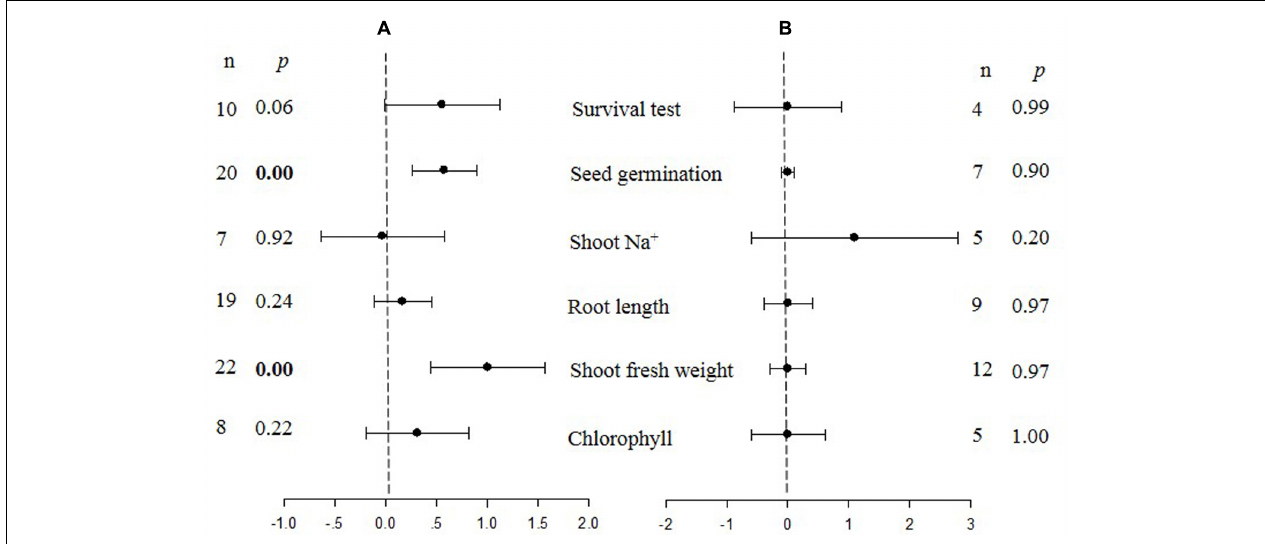
FIGURE 2 | Weighted summary effect sizes (ln R ) and 95% CIs for the effect of CBL overexpression in transgenic plants subjected to NaCl stress conditions (A) and non-stress conditions (B) . A p ≤ 0.05 indicates that the moderator level was significantly different than zero; n stands for the number of